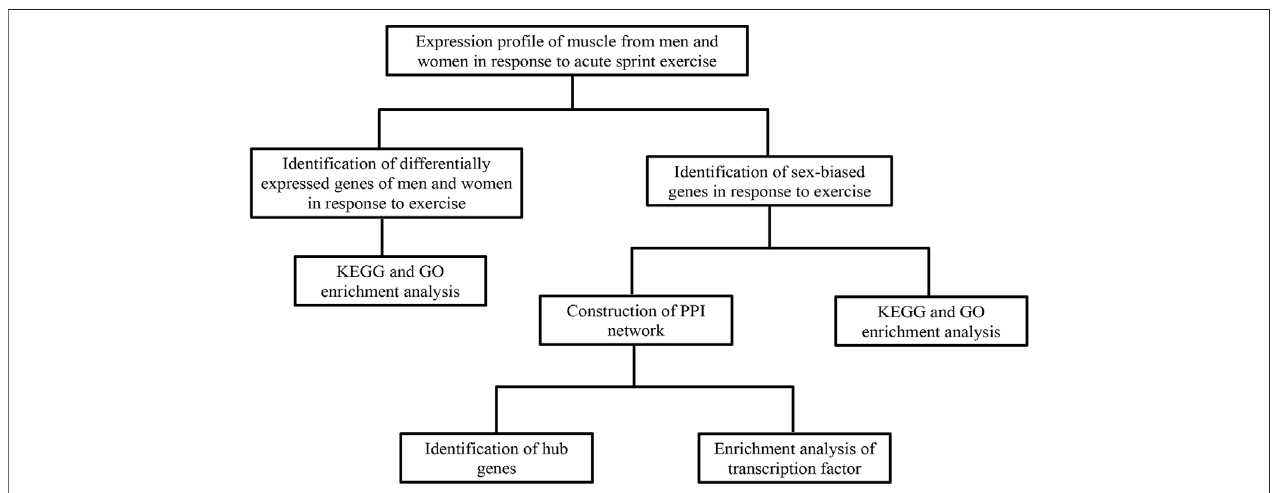
FIGURE 1 | A fl owchart of analytical approaches used in this study. GEO, Gene Expression Omnibus; GO, Gene Ontology; KEGG, Kyoto Encyclopedia of Genes and